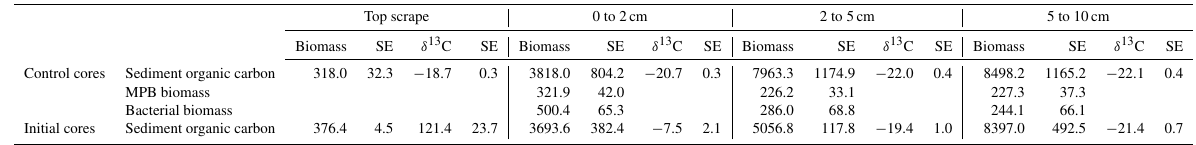
Table 1. The δ 13 C values (‰) and carbon biomass (µmolCm − 2 ) for control (natural abundance, n = 3) and initially labeled cores ( n = 3, 0 days). Microphytobenthos and bacterial biomasses are only provided for control